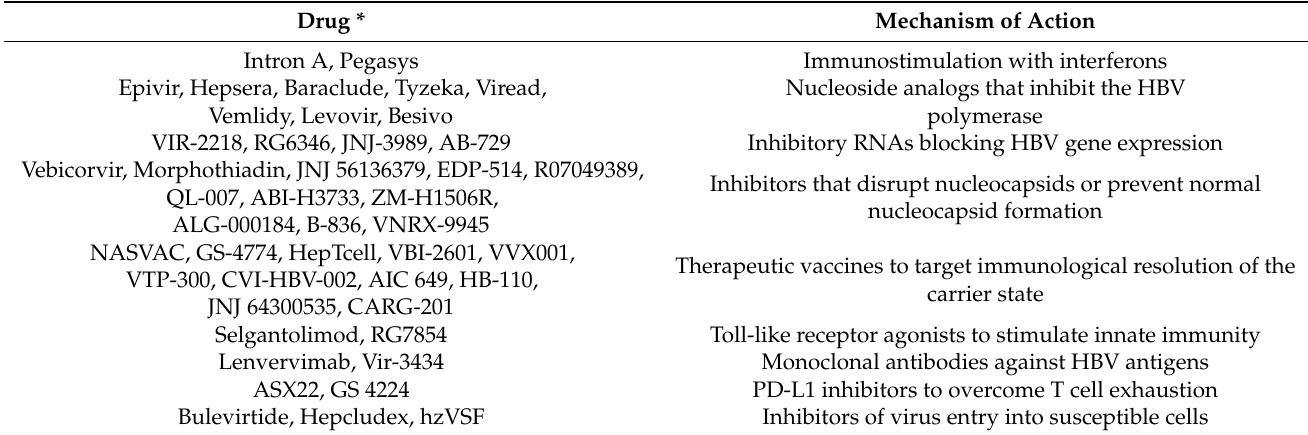
Table 1. Therapeutic Approaches Aiming to Cure HBV Infection